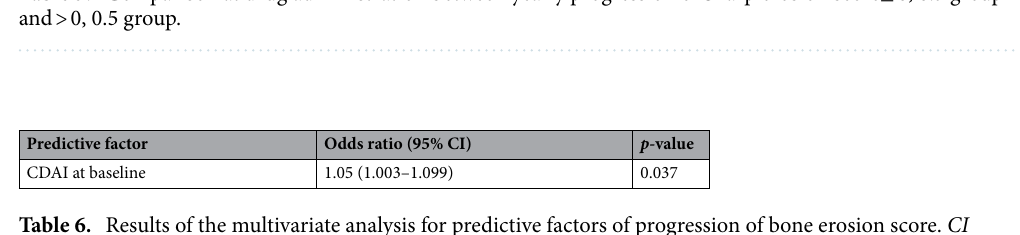
Table 6. Results of the multivariate analysis for predictive factors of progression of bone erosion score. CI confidence interval, CDAI Clinical disease activity index.